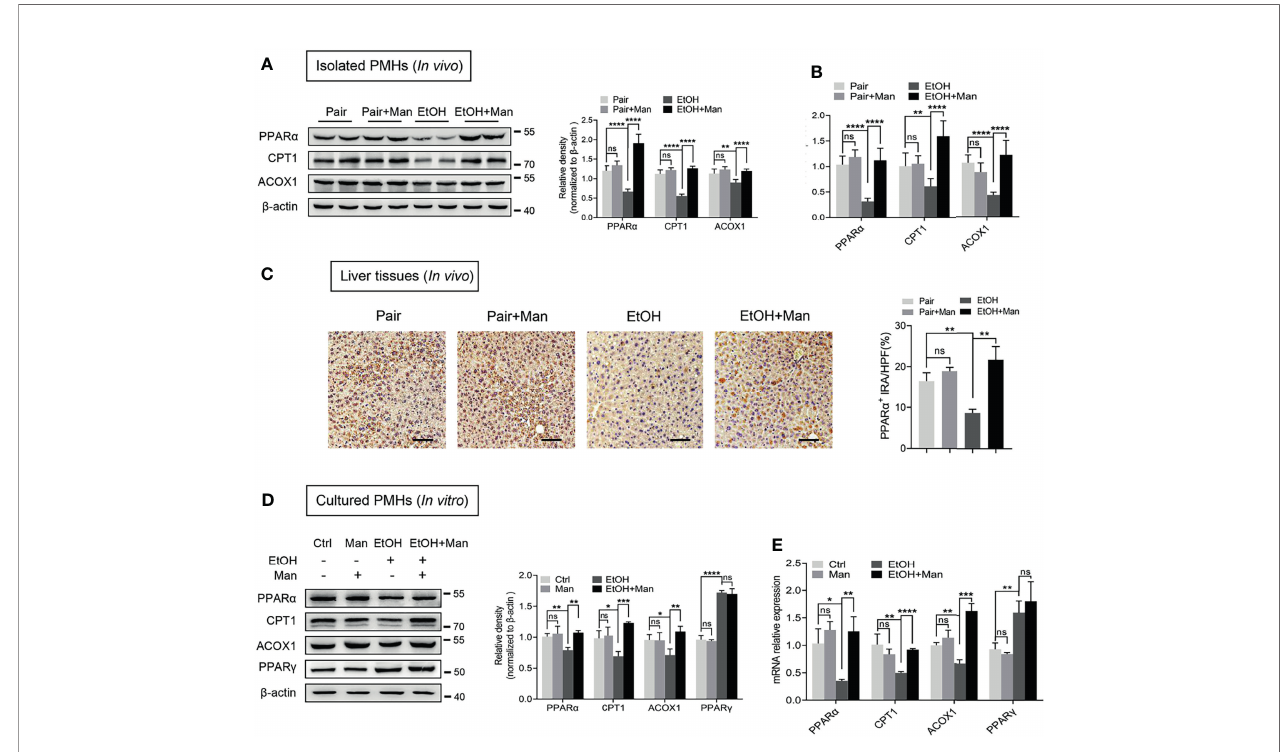
FIGURE 3 | Mannose suppresses ethanol-mediated reduction of hepatocyte fatty acid oxidation. (A – C) PMHs were extracted from mice (n = 6 for each group) fed the control diet (Pair) or ethanol diet (EtOH) supplemented with/without 3% (w/v) mannose (Man). The protein (A) and mRNA (B) levels of PPAR a , CPT1, ACOX1 were evaluated by Western blotting and qRT-PCR, respectively. (C) Representative images of PPAR a staining on the liver sections (n = 3). Scale bars = 100 m m. (D, E) PMHs from WT mice were stimulated by 200 mM ethanol (EtOH) with/without 5 mM mannose (Man) for 24 h, PMHs with cell culture medium as control (Ctrl). The protein (D) and mRNA (E) levels of PPAR a , CPT1, ACOX1 and PPAR g were determined (n = 3). Data are expressed as the mean ± SEM of three independent experiments. * p < 0.05, ** p < 0.01, *** p < 0.001, **** p < 0.0001, ns, not signi fi cant, unpaired two-tailed t